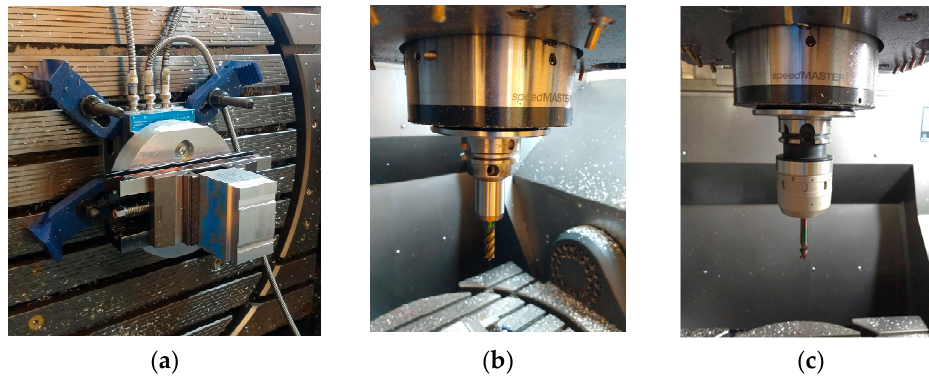
Figure 6. ( a ) experimental set-up ( b ) tool 1 ( c ) tool 2